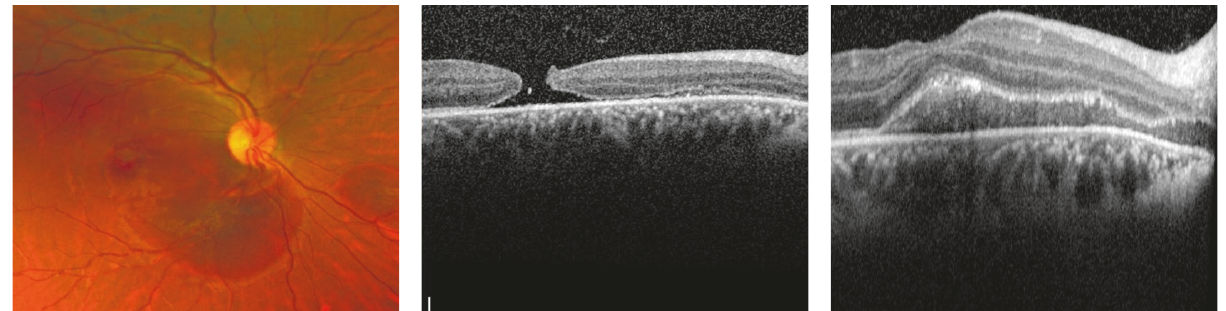
Figure 2: Fundus photograph and Spectral-Domain Optical Coherence Tomography (SD-OCT) of the right eye one week after presentation demonstrating macular hole (MH) and inferior submacular hemorrhage (SMH).